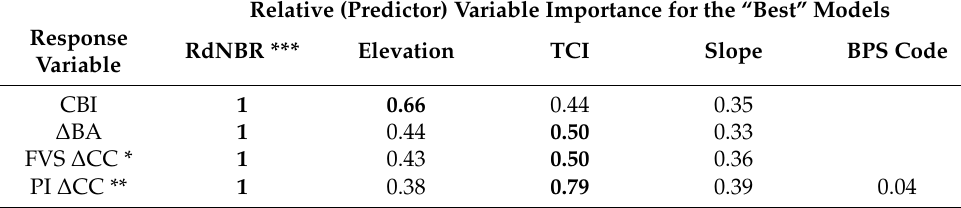
Figure A3. Kendall’s tau correlations between response variables (CBI, Δ CC, and Δ BA) and topo- graphic and ecological variables. Table A2. Relative variable importance for the “best” models for each response variable. Predictor variables with RVI ≥ 0.50 are in bold.